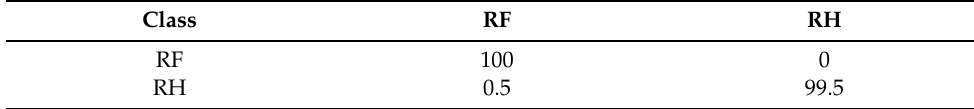
Table 6. Confusion matrix of RF and